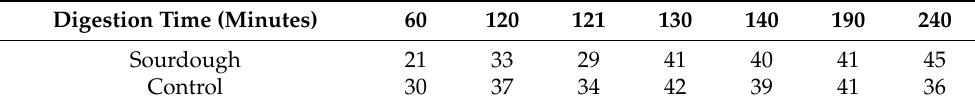
Table 2. The number of immunogenic peptides detected during in vitro digestion of sourdough and fast fermentation